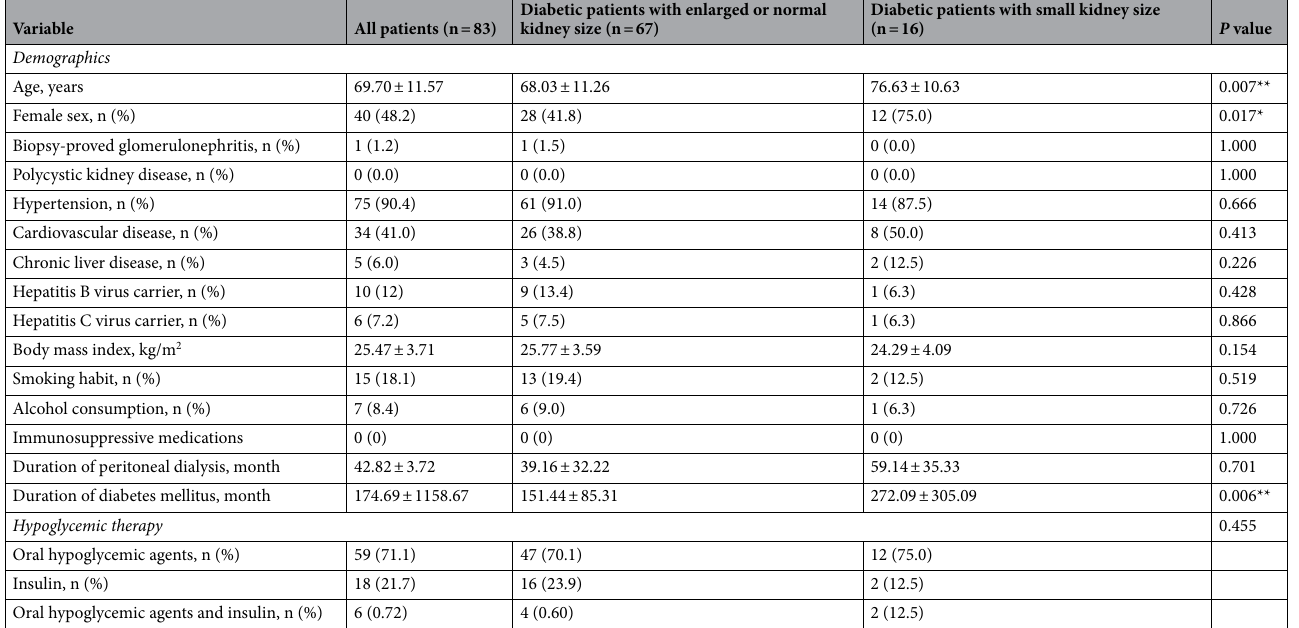
Table 1. Baseline characteristics of peritoneal dialysis patients stratified by kidney size (n = 83). * P < 0.05; ** P <